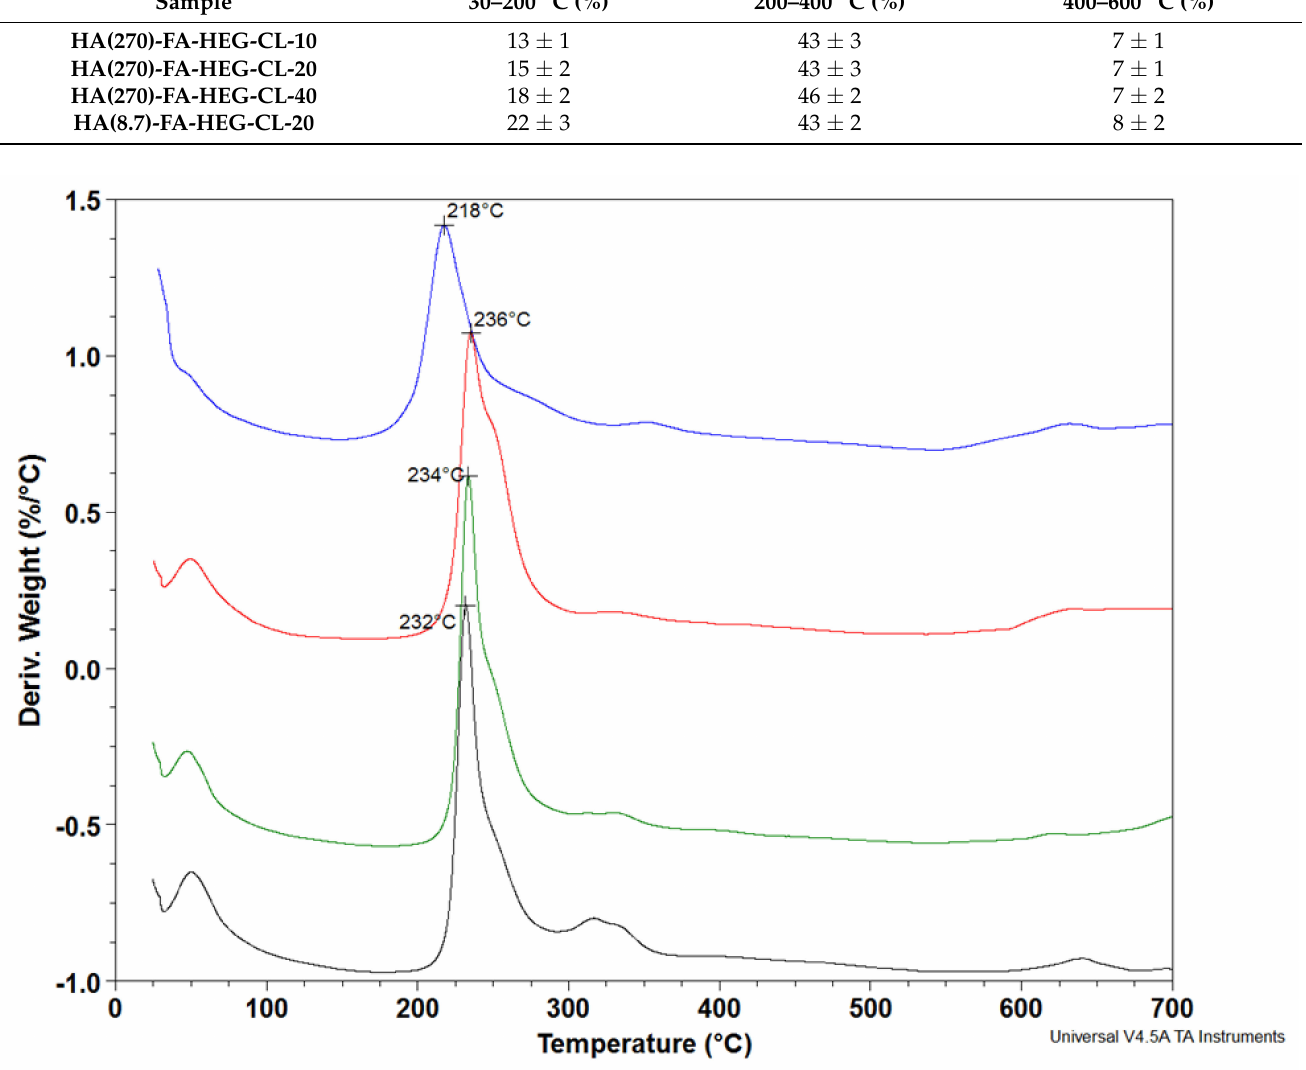
Table 5. The TGA/DTG analysis of samples. Data were reported as percent mean value ± SD ( n = 3). Sample